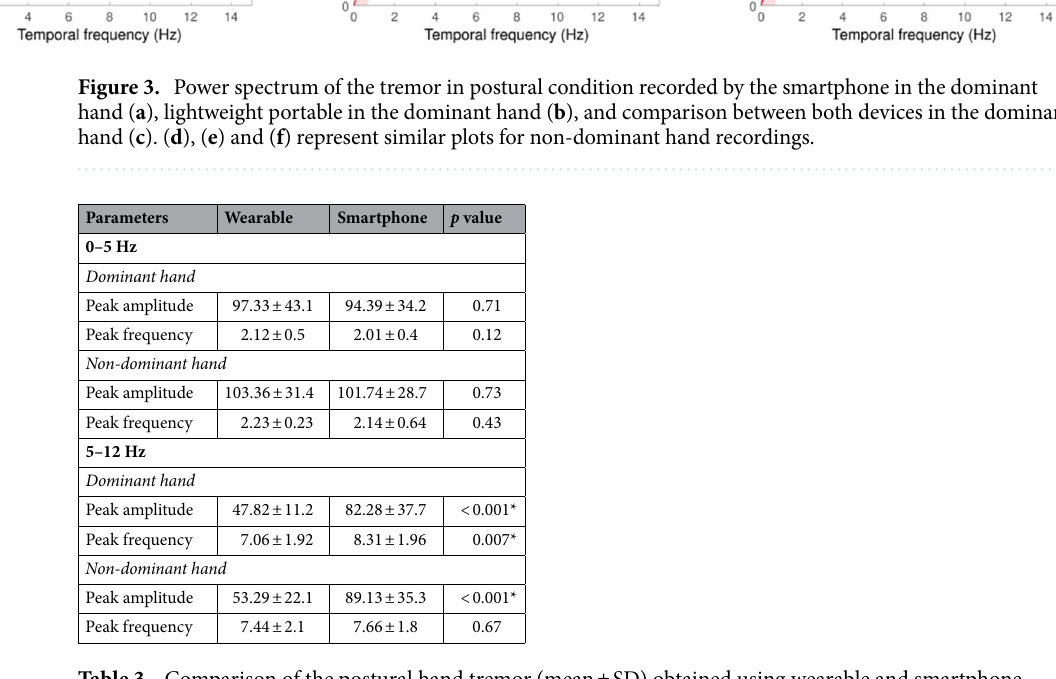
Table 3. Comparison of the postural hand tremor (mean ± SD) obtained using wearable and smartphone devices.